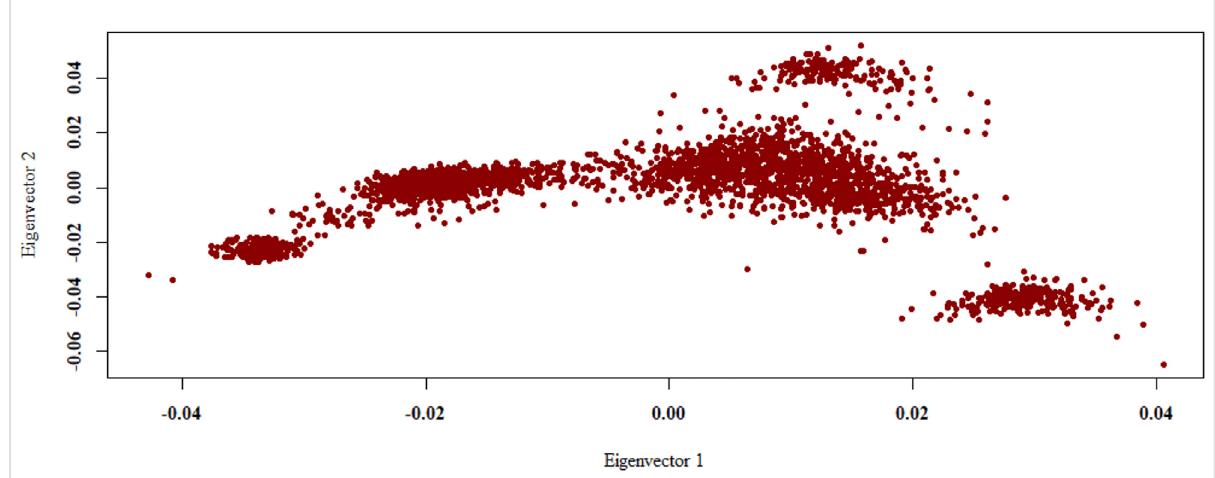
FIGURE 3 Populationstructurefromtheprincipalcomponentanalysis.Population structureisshownasaplotofthe fi rsttwoprincipalcomponents(PCs). PCA was conducted with the 8,686,483 loci for 3,016